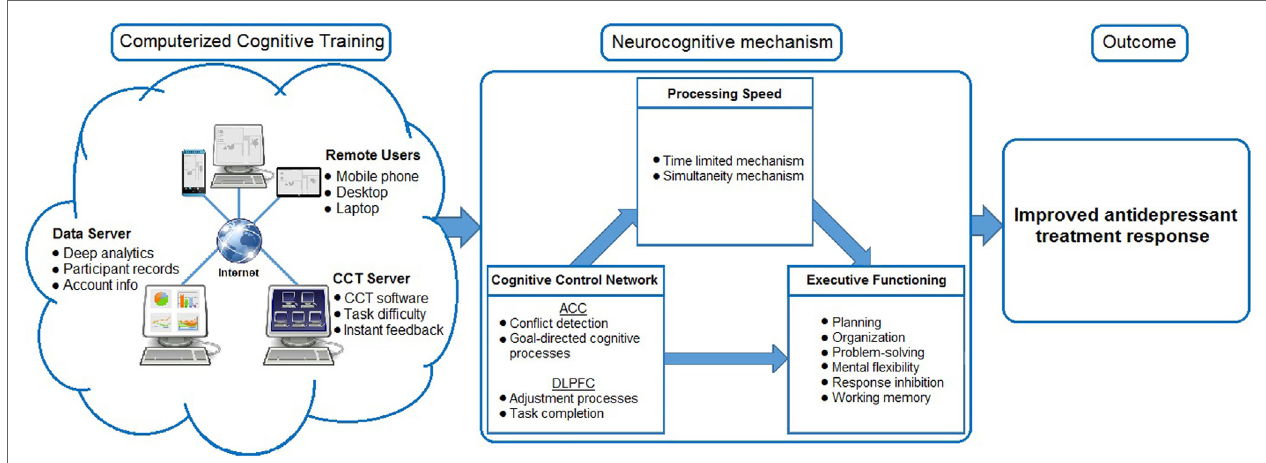
FiGURE 1 | Model of improved antidepressant response